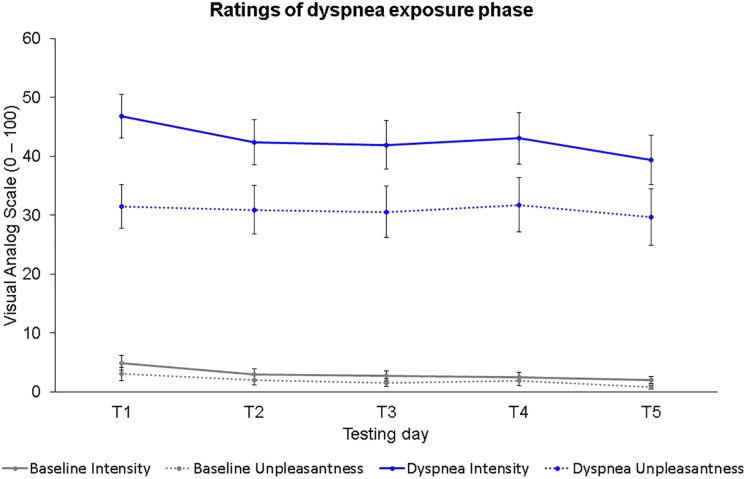
Dyspnea intensity and dyspnea unpleasantness ratings for all five testing days during the dyspnea exposure phases. Dots represent mean values. Error bars represent standard errors.